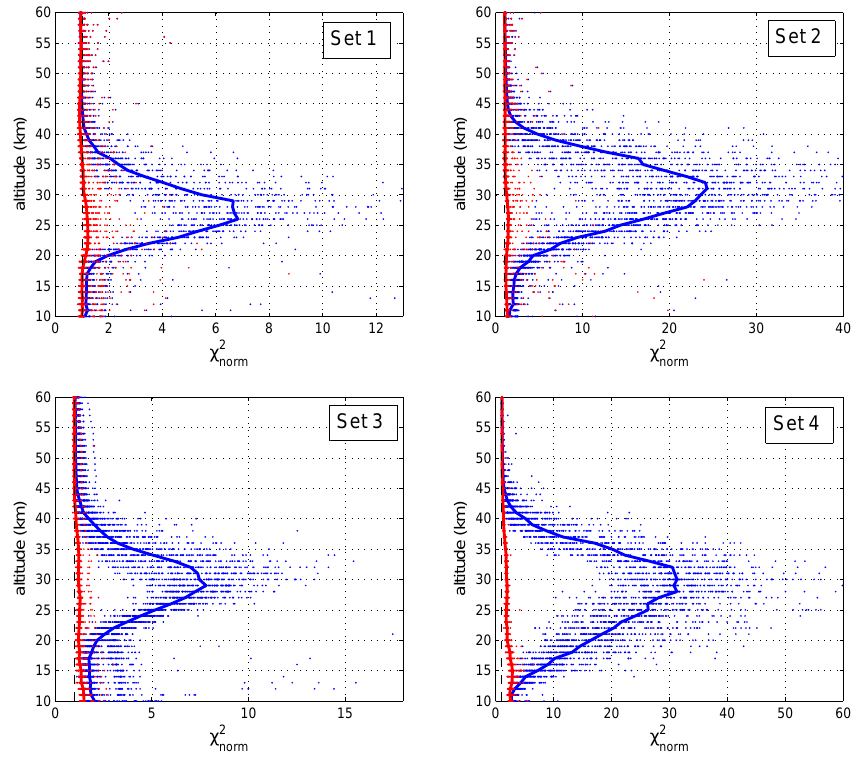
Fig. 2. χ 2 in retrievals. Blue: modeling errors are ignored, red: “full covariance matrix” inversion. Dots: values in individual occultations, bold lines indicate median values for the sets. The black dashed lines indicate χ 2 norm =1.